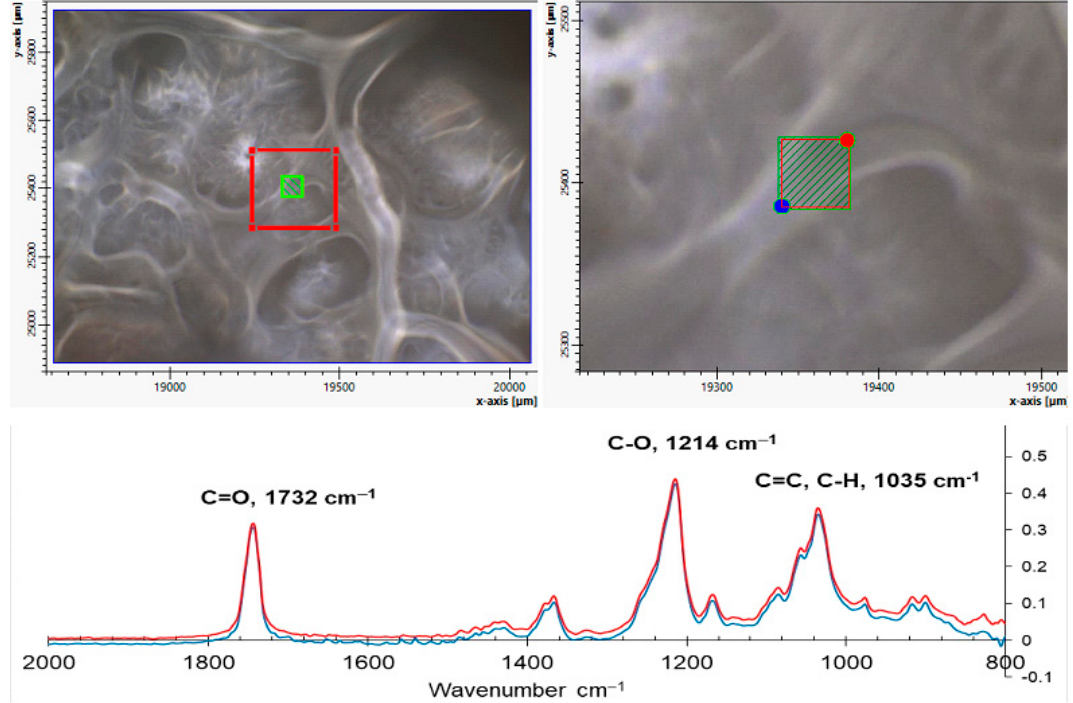
Figure 6. IR imaging spectra of the gel formed by compound 7a at 10.0 mg/mL in EtOH:H 2 O (1:2), the bottom are absorbance IR spectra of the areas marked inside the box.